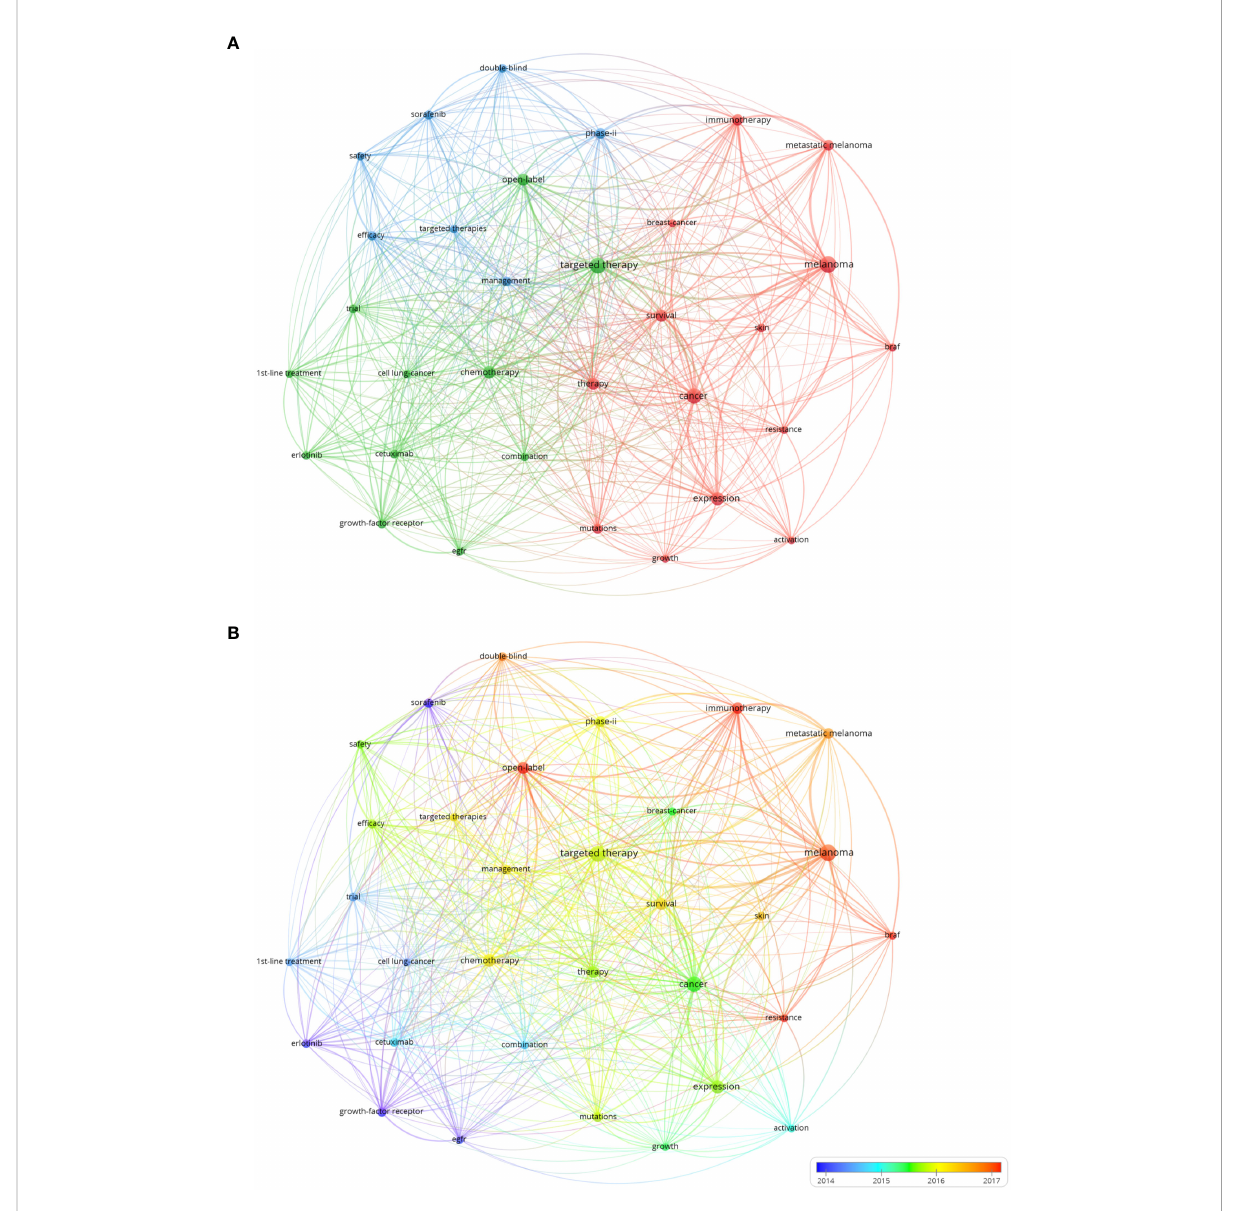
FIGURE 8 (A) The network visualization map of keywords generated by VOS viewer (version5.8 R3). (B) The visualization map of keywords over time by VOS viewer (version5.8